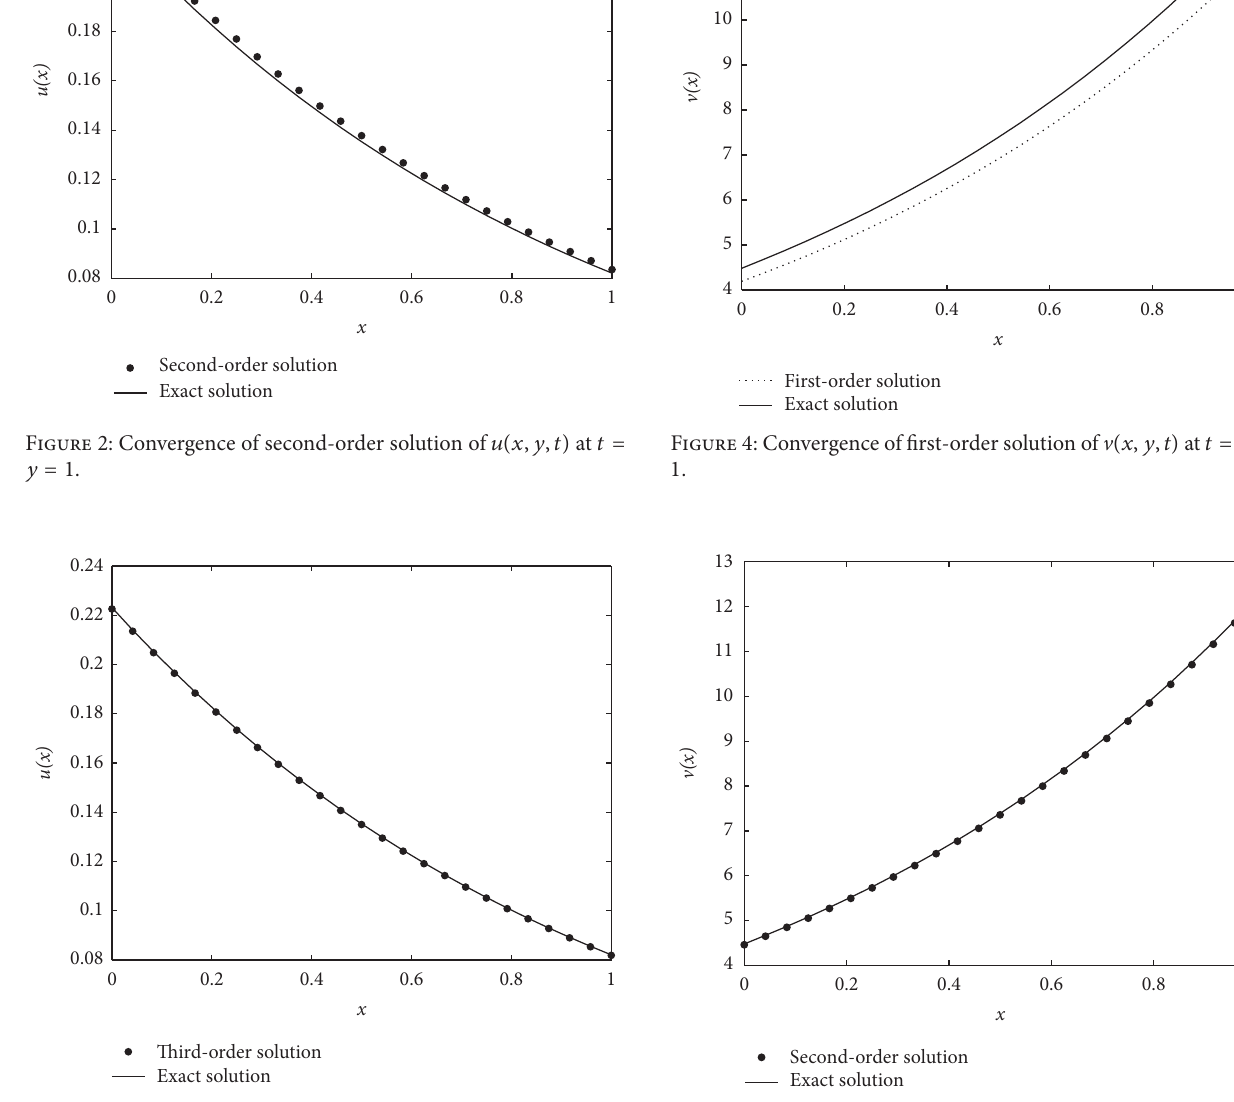
Figure 5: Convergence of second-order solution of V (𝑥, 𝑦,𝑡) at 𝑡 = 𝑦 = 1